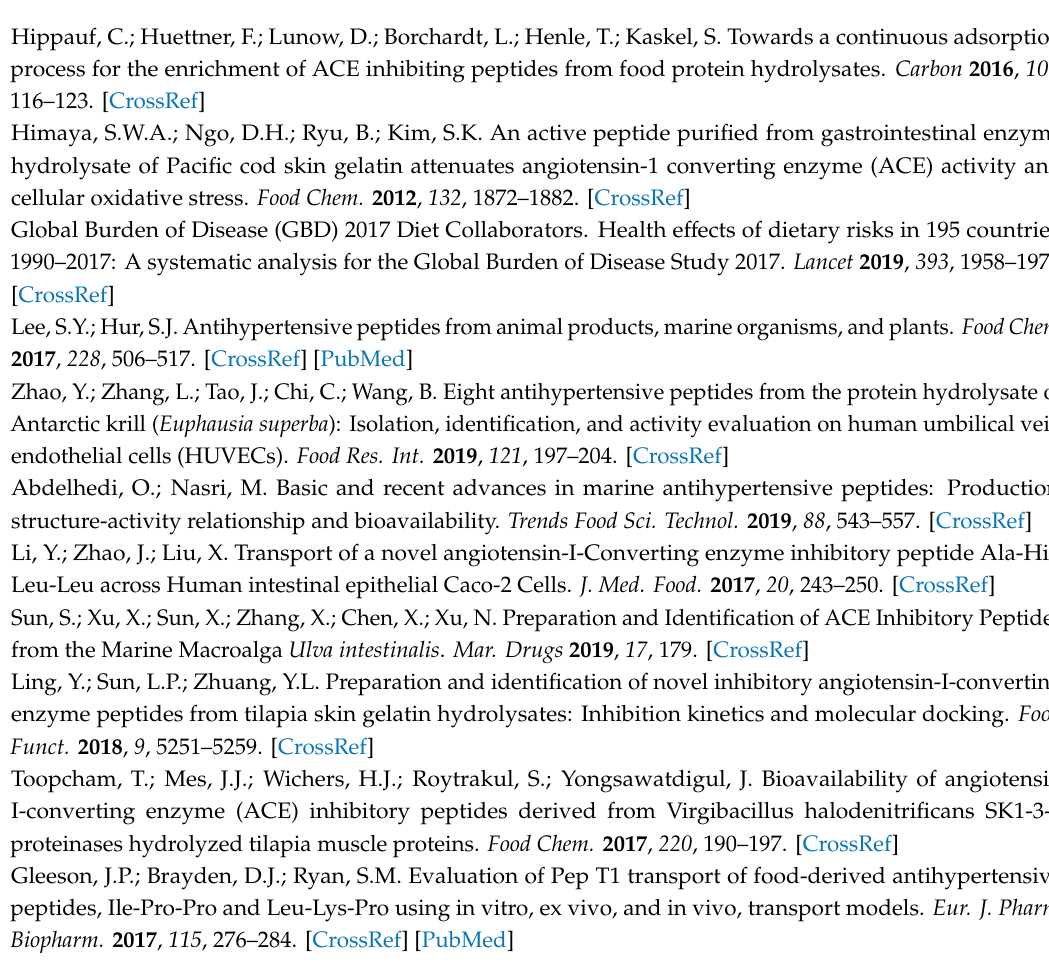
Figure S1: HPLC analysis of peptide RWDISQPY on Kromasil 100-5 C 18 column (4.6 × 250 mm); Figure S2: The MS / MS analysis of the identified peptide RWDISQPY; Figure S3: E ff ects of RWDISQPY on body weight (A) and heart rate (B) of spontaneous hypertensive rats